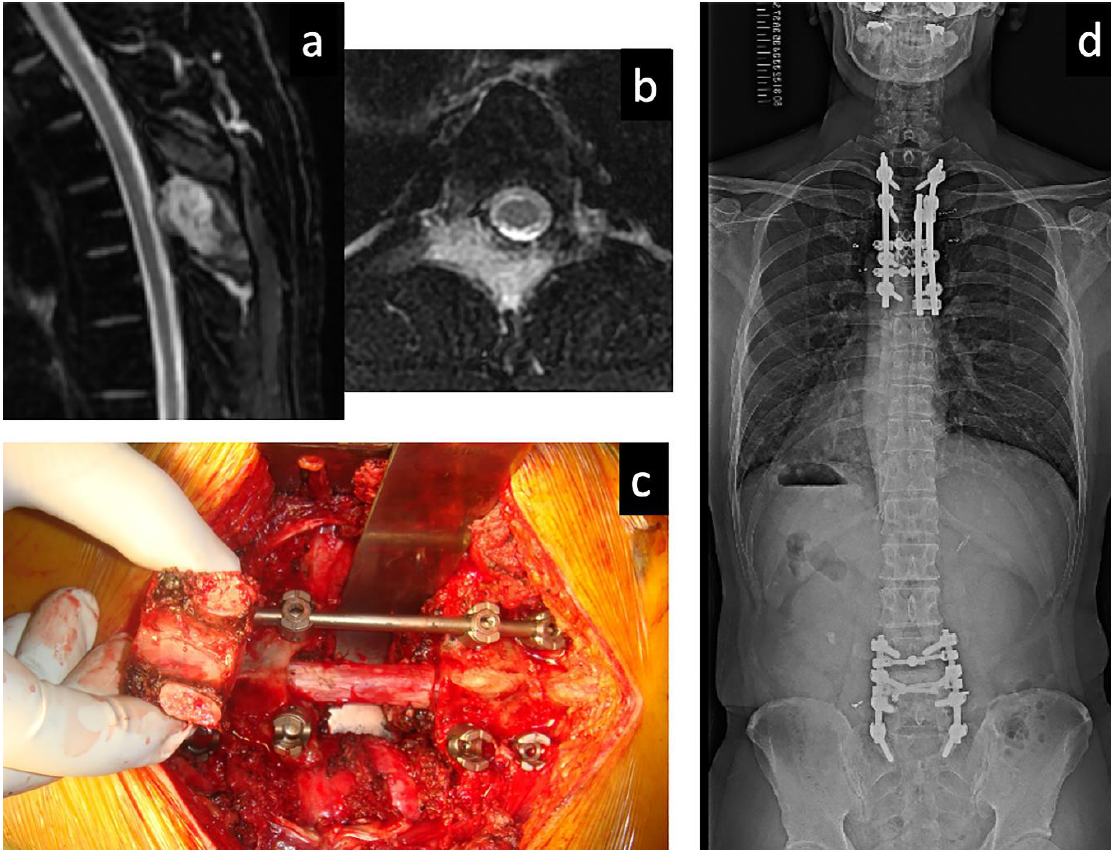
Figure 1. A 39-year-old man diagnosed with multiple lung and spinal metastases of T4 and L4. He underwent metastasec- tomies for spinal lesions. He also underwent radioactive iodine (RAI) therapy after the spinal metastasectomies and other metastasectomies for BMs, which subsequently appeared in the sacrum, left ilium, and humerus after RAI therapy. Eleven years after the first metastasectomy, he had no local tumor recurrences in the operated lesions; he still performed his normal daily activities and worked without any difficulties. ( a ) Sagittal and ( b ) axial T2-weighted magnetic resonance imaging of the thoracic spine, showing metastasis of T4. ( c ) Spondylectomy of T4 (complete resection of the tumor-affected vertebra) without any significant perioperative complications. ( d ) A recent full-spine radiography showing good maintenance of the reconstructed spine.